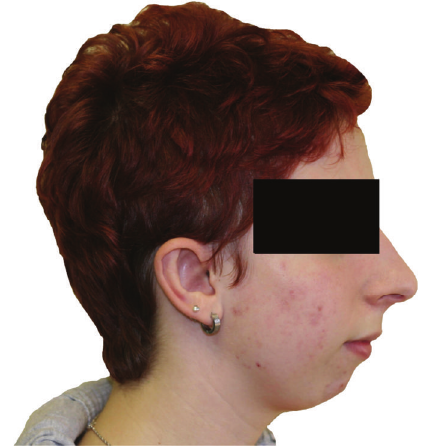
Figure 1: Mild form of Treacher Collins syndrome (TCS). Patient did not present other facial abnormalities except mild retrognathia.